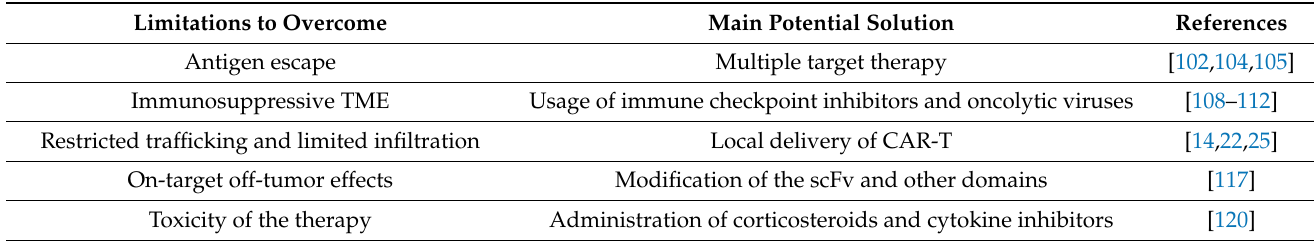
Table 3. The summary of main obstacles associated with targeting CAR-T cells into solid tumors and the main ways to handle